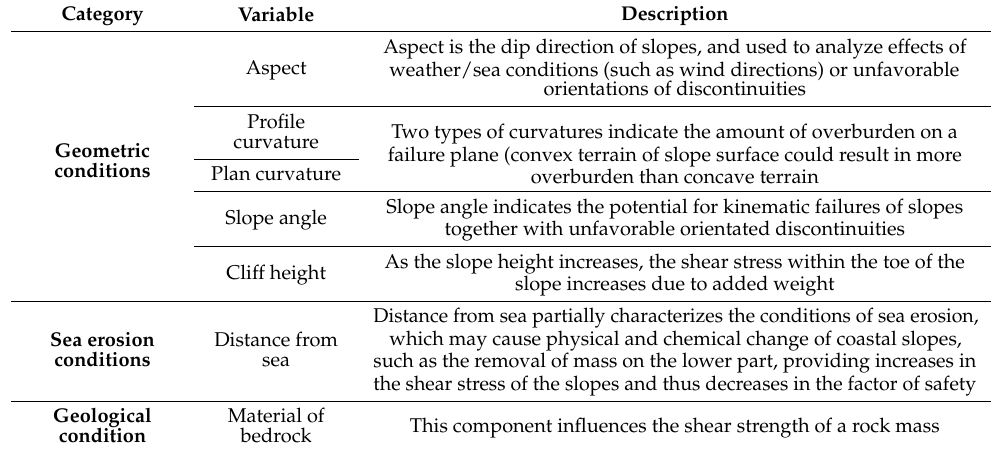
Table 2. Selected input variables associated with geometric conditions, sea erosion conditions and geological conditions, and the description of their relationship with